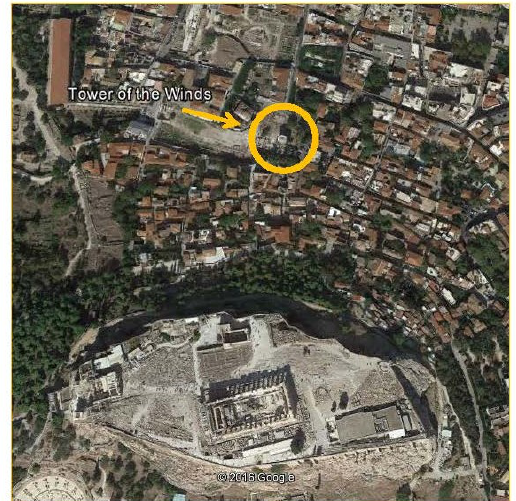
Figure 1: The location of the Tower of Winds in relation to the Acropolis